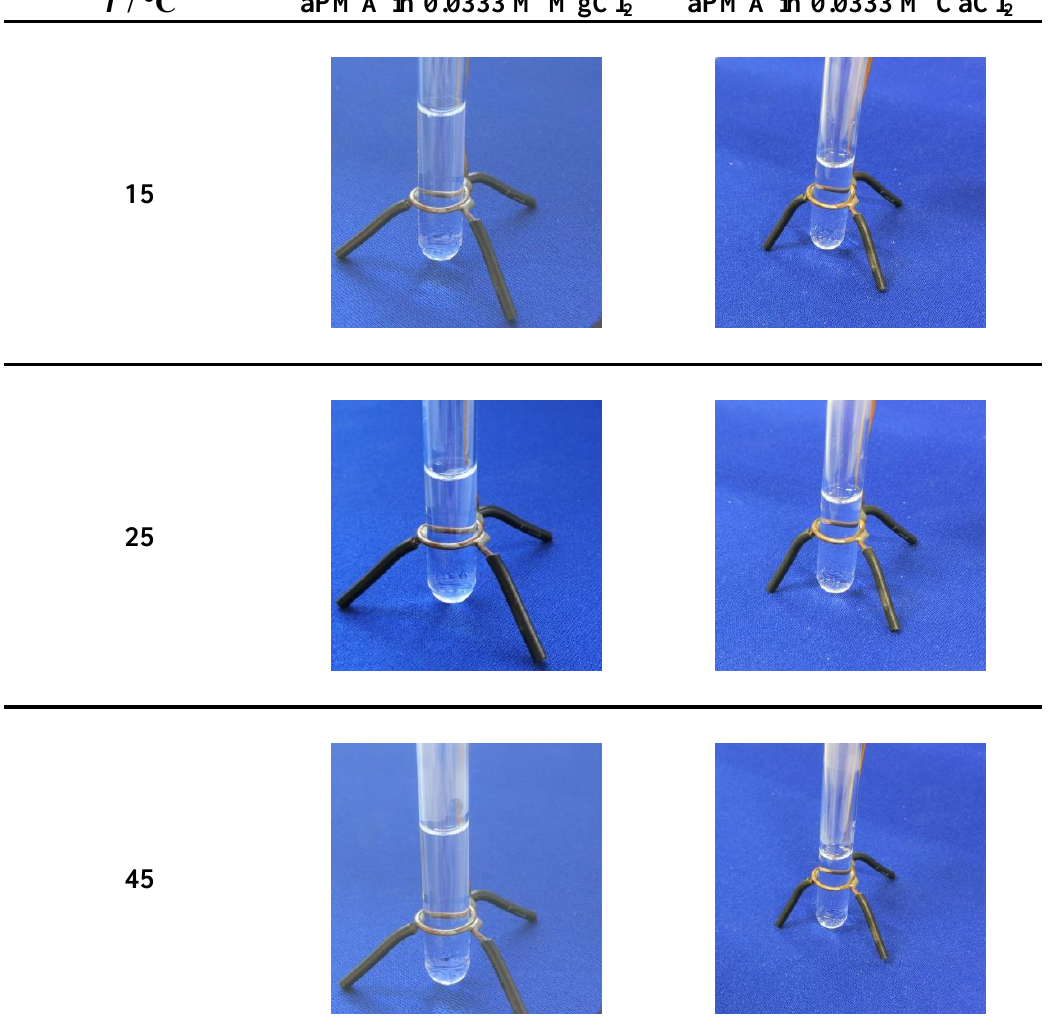
= 0.023 mol L -1 , α = 0) samples in the presence of MgCl p N